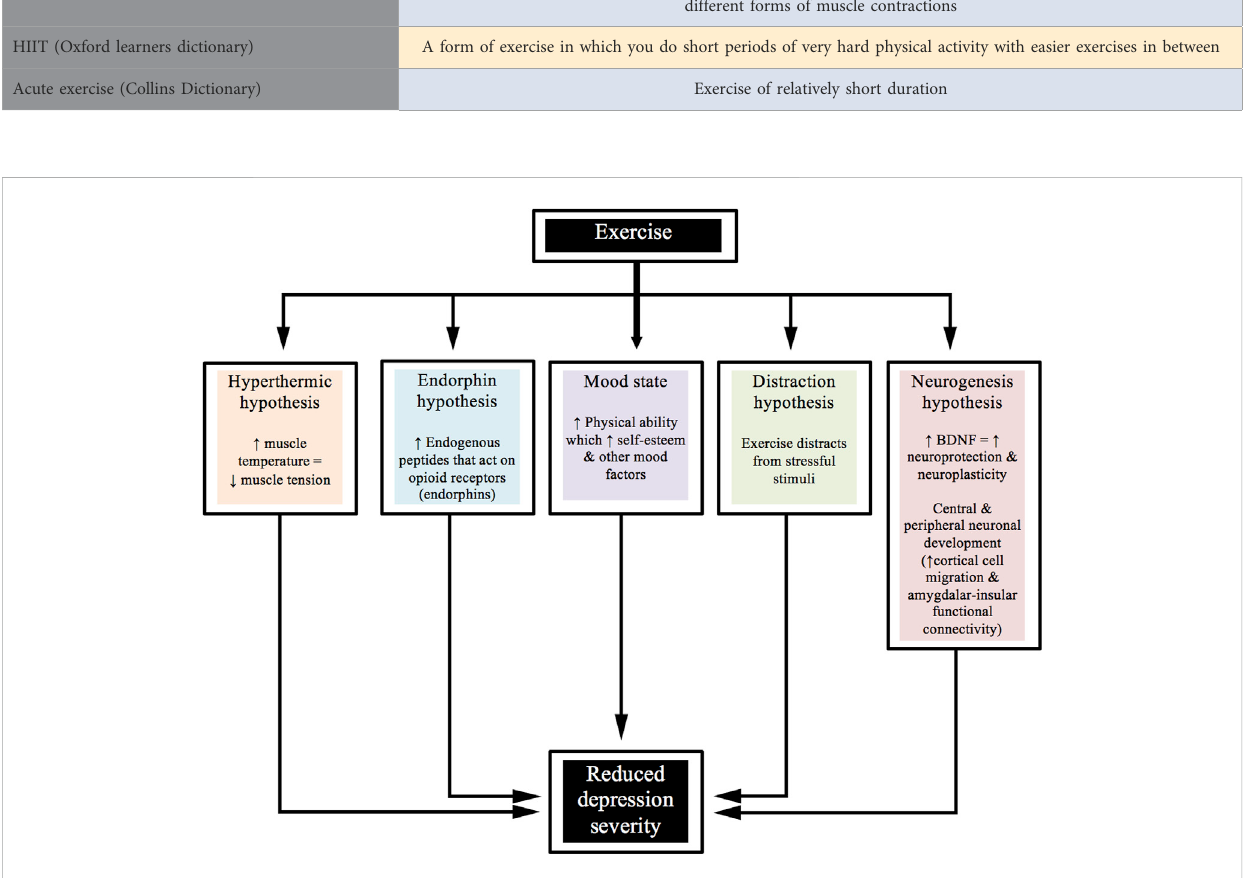
Bene fi cial effects of exercise on the severity of